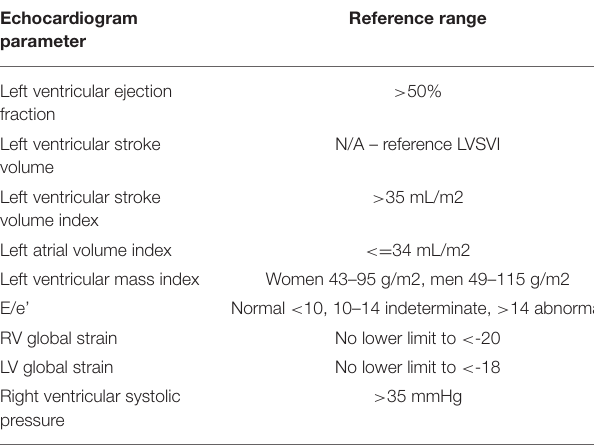
TABLE 5 | Reference ranges for echocardiography measures.